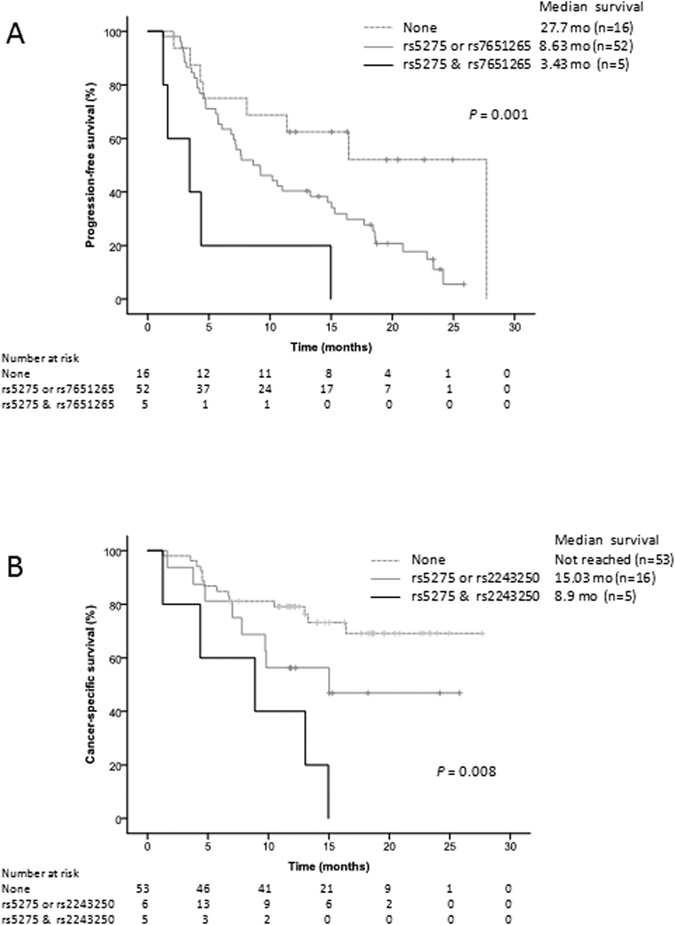
Kaplan-Meier curves for each of the proposed two-SNPs models. (A) Progression-free survival for patients grouped by adverse genotypes in rs5275 (PTGS2) and rs7651265 (PIK3CA). (B) Cancer-specific survival for patients stratified according to combination of deleterious genotypes in rs5275 (PTGS2) and rs2243250 (IL4).